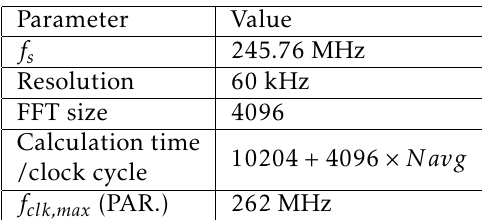
Table 1. Detection performance